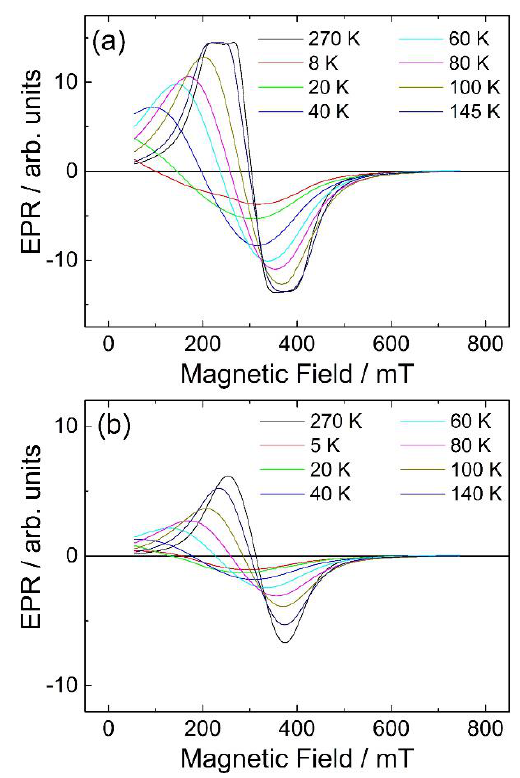
Figure 8. Hysteresis curves measured at 4.2 K (red) and 300 K (blue) of Fe substituted γ -Ga 2 O 3 for 1 samples ( a ) Fe:Ga 1:1 and ( b ) Fe:Ga 3:7. The insets show expansion of the curves in the low-field region.